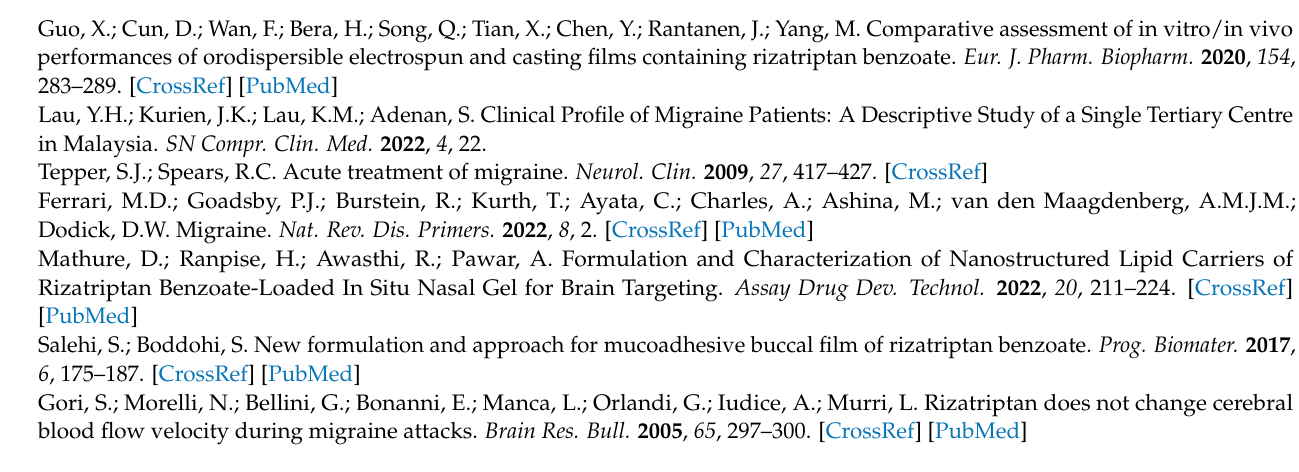
RZT-ODFs using solvent casting method; Figure S2: Schematic diagram of blood sampling treatment for pharmacokinetics studies; Figure S3: Effect of polymeric material on the thickness and D-time of RZT-ODFs; Figure S4: Effect of plasticizer percentage on folding endurance; Figure S5: Effect of polymeric materials ratio on folding endurance; Figure S6: Surface pH values of RZT-ODFs; Figure S7: Effect of plasticizer level on the water content of RZT-ODFs; Figure S8: Effect of MDX concentration on moisture uptake of RZT-ODFs; Figure S9: Desirability ramp for numerical optimization of seven selected goals (A), over plot (B), and model desirability (C); Figure S10: Chromatograms of (a) blank plasma, (b) RZT, (c) zolmitriptan (IS), (d) RZT and IS; Table S1: Feasibility, pH and drug content (%) determination of RZT-ODFs; Table S2: Model summary and statistics (A), ANOVA for thickness (Y 1 ) surface linear model (B); Table S3: Model summary and statistics (A), ANOVA for folding endurance (Y 2 ), linear surface model (B); Table S4: Model summary, statistics and ANOVA for tensile strength (Y 3 ) surface linear model; Table S5: Model summary and statistics and ANOVA for % E (Y 4 ) surface linear model; Table S6: Model summary and statistics and ANOVA for water content (Y 5 ) surface linear model; Table S7: Model summary and statistics and ANOVA for water absorption (Y 6 ) surface linear model; Table S8: Model summary, statistics and ANOVA for D-time (Y 7 ) surface linear